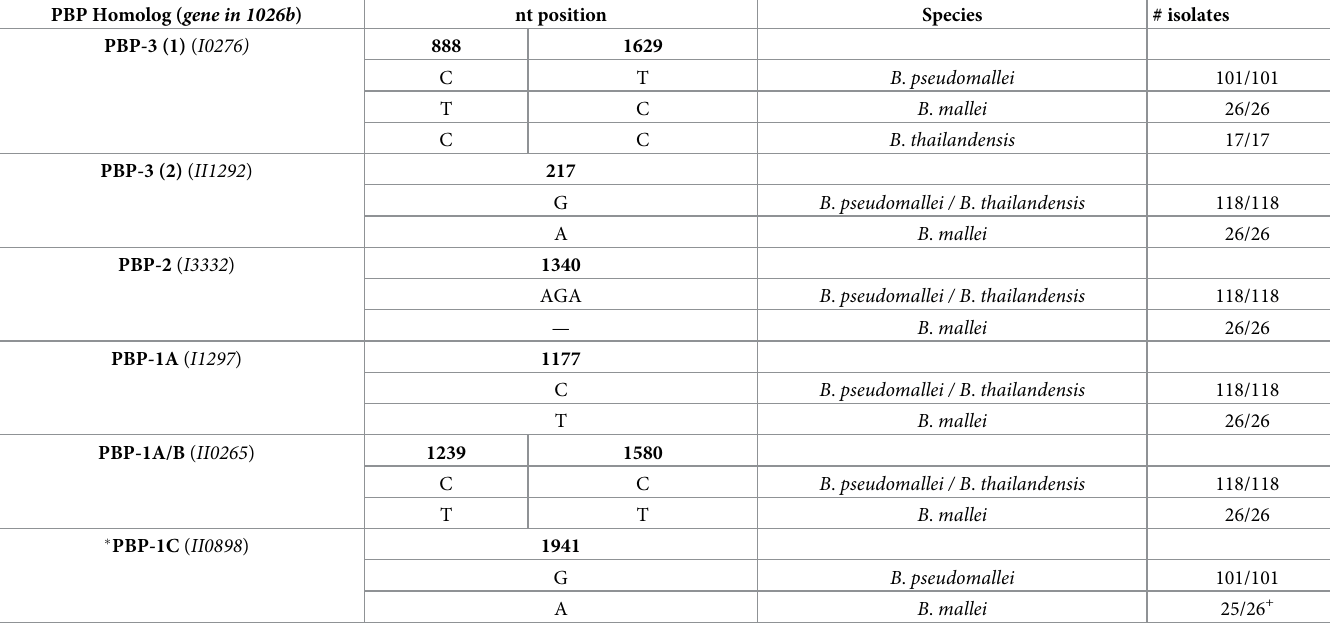
Table 3. PBP SNPs with utility for differentiation of Burkholderia